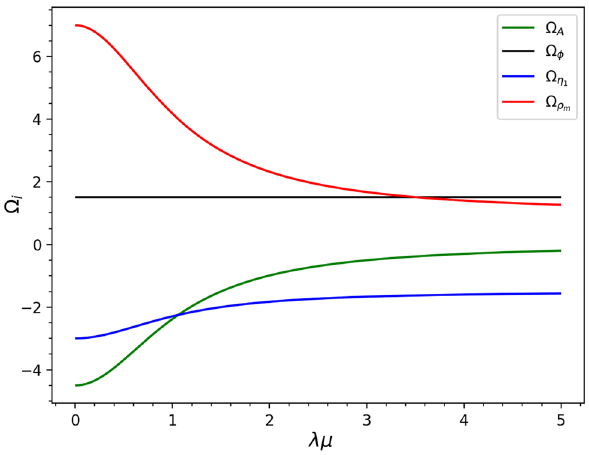
and (cid:12) ρ , respectively m 1